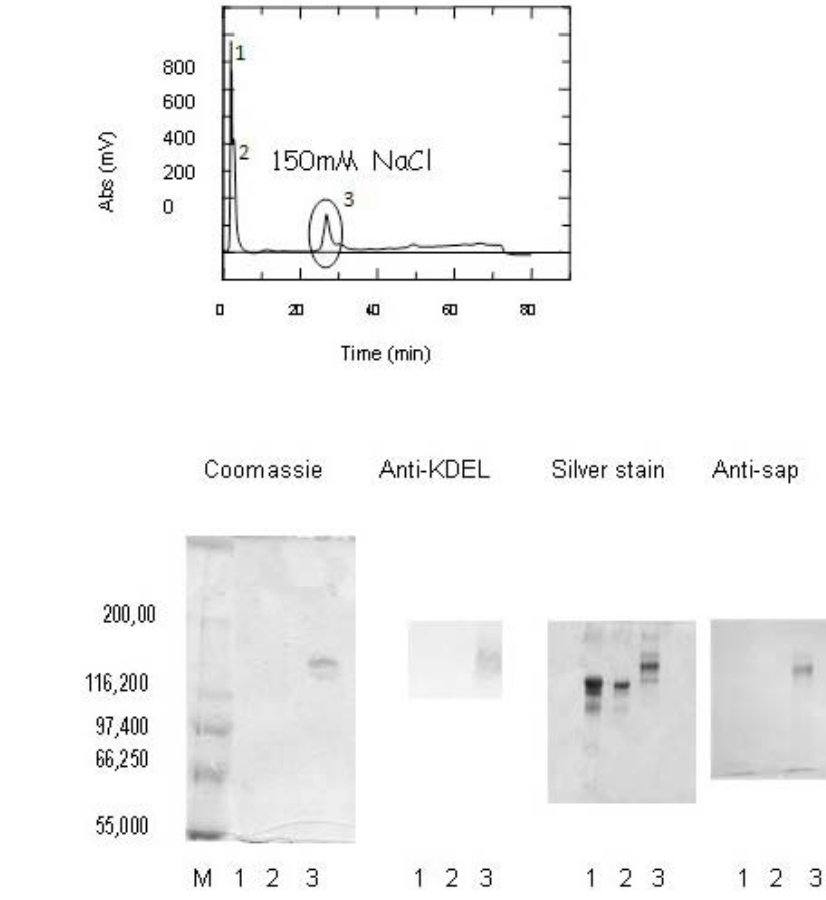
conjugate. The KDEL